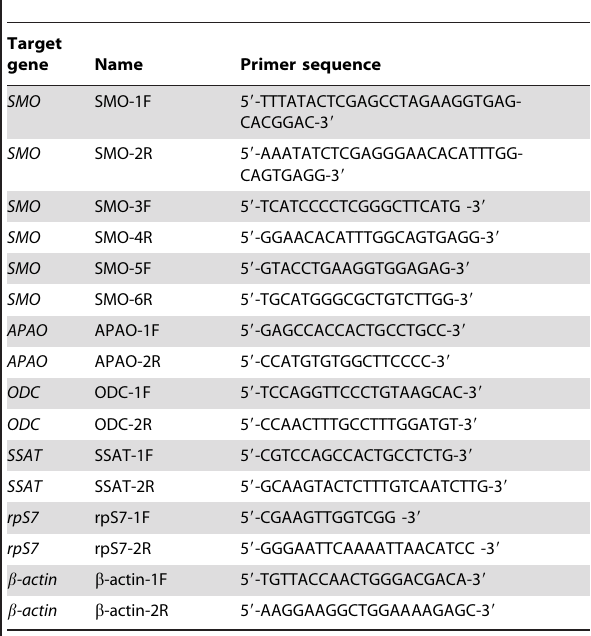
Table 1. Primers used in this